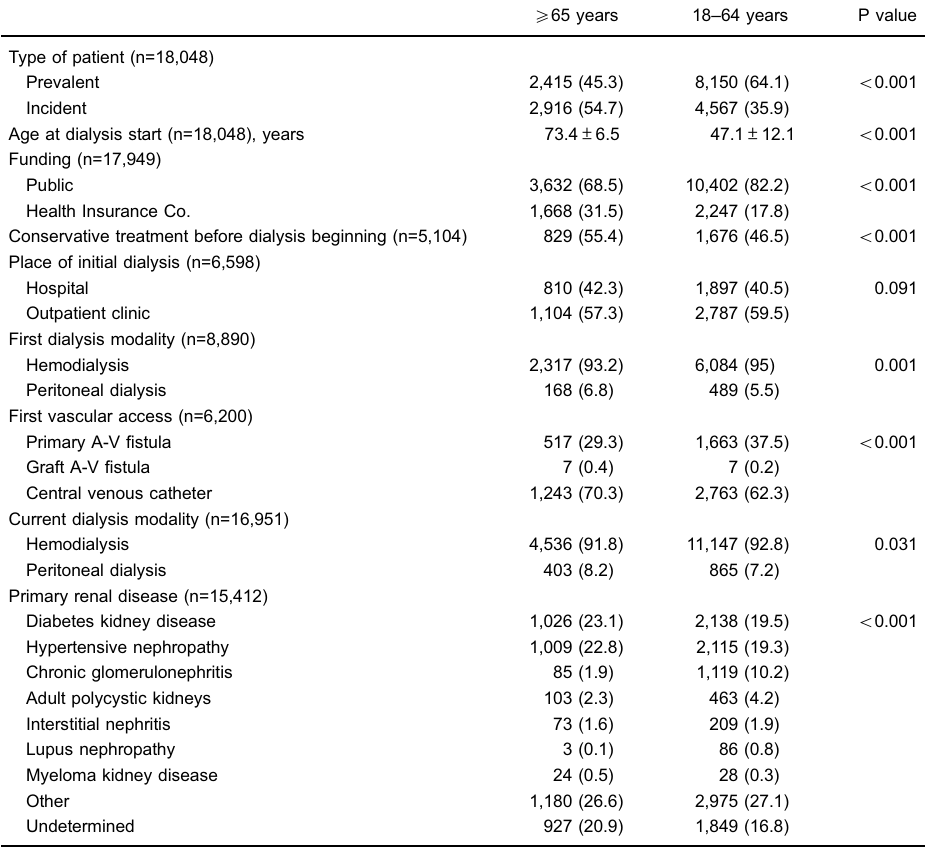
Table 2. Selected characteristics of the dialysis treatment by age